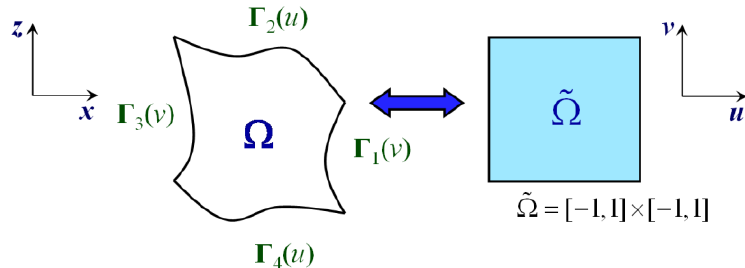
Fig. 2. Mapping of the curve-bounded quadrilateral to the reference